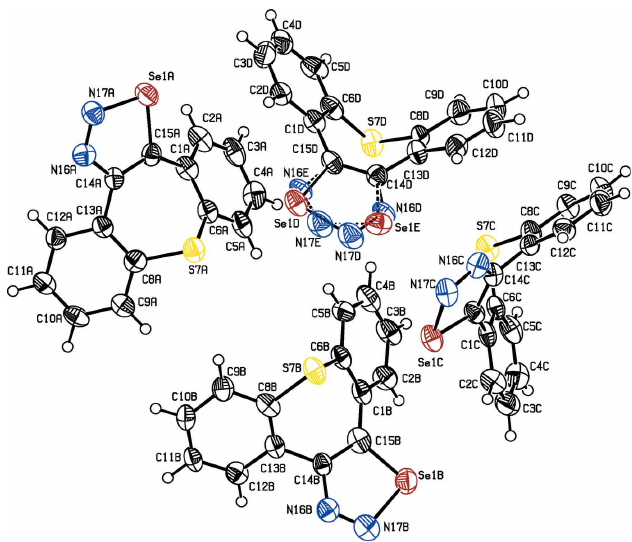
Figure 1 The structures of the four molecules present in the asymmetric unit of the title compound. Displacement ellipsoids are drawn at the 50% probability level. The minor disorder component is shown with dashed lines.